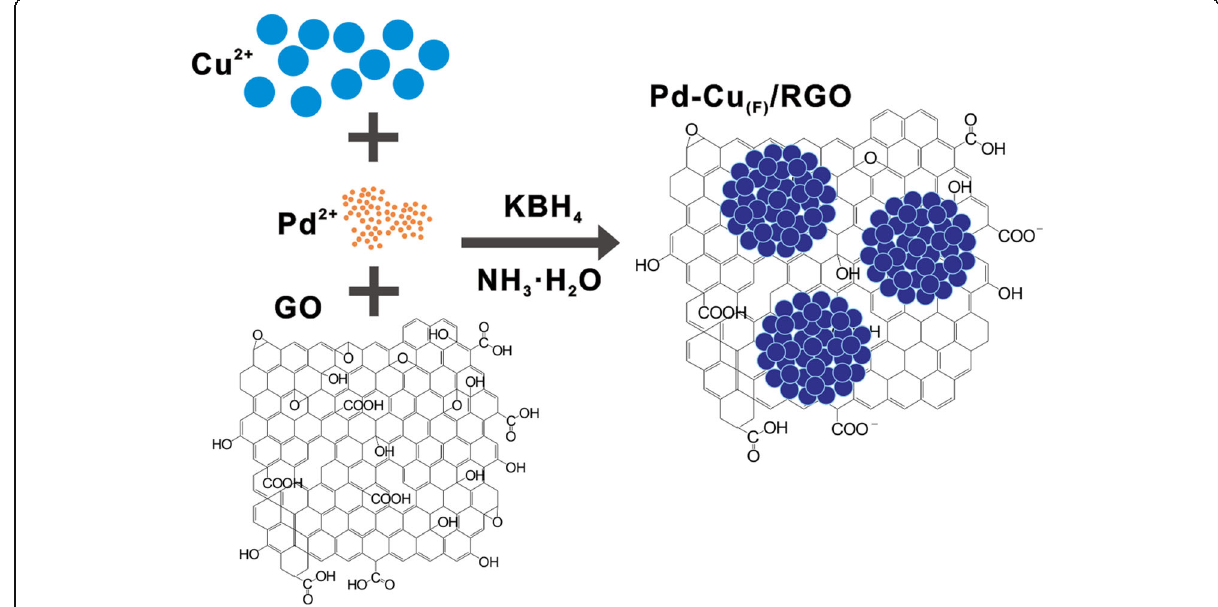
Fig. 5 Schematic illustration of the preparation of Pd-Cu (F) /RGO nanostructures